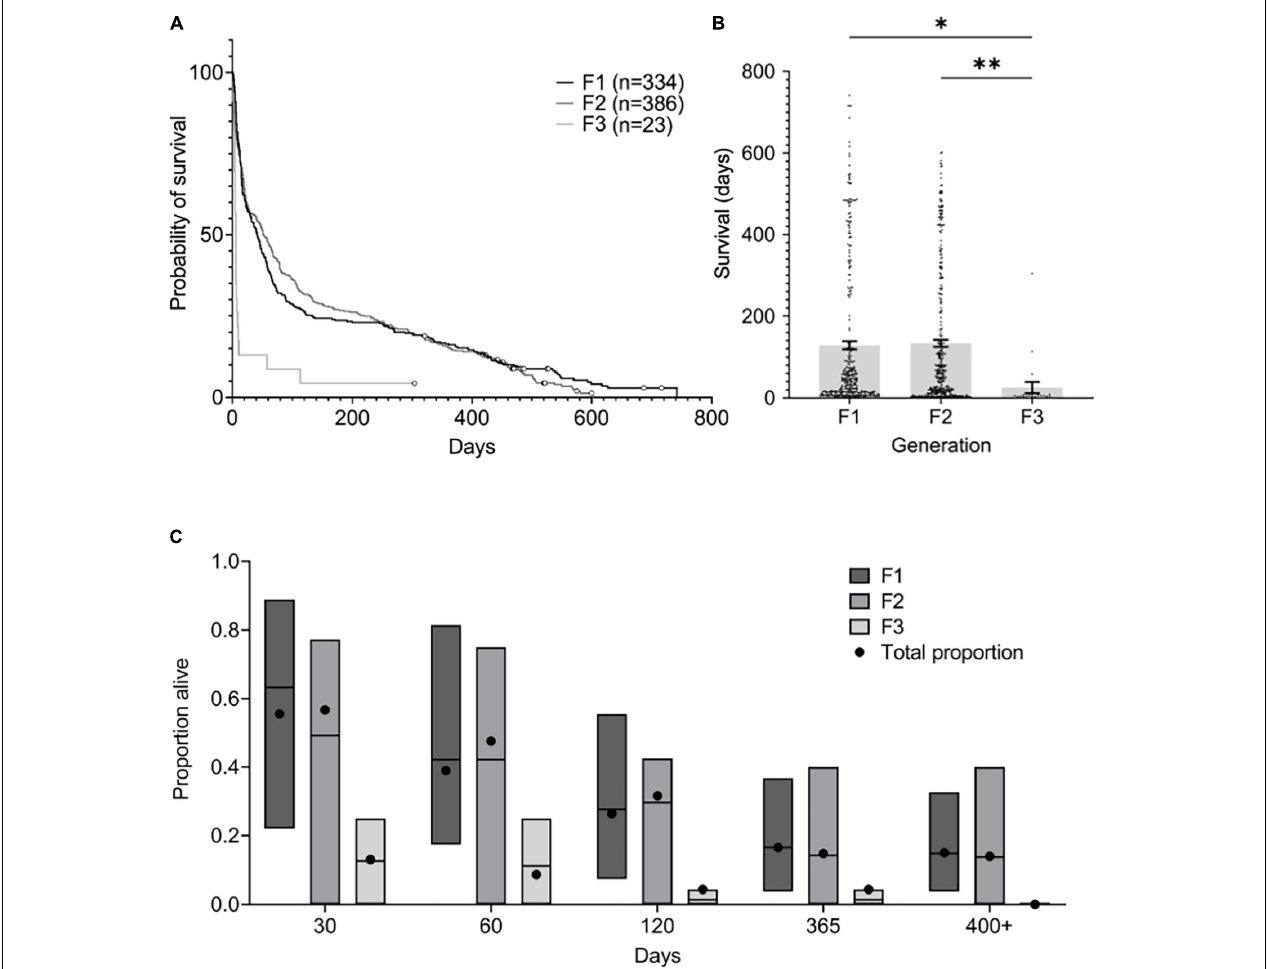
FIGURE 6 | Octopus chierchiae survival by generation. Mortality data was pooled and grouped by generation. (A) Survival curve by generation. Individuals surviving to the end of the study were treated as censored observations, represented by circles. (B) Survival (in days) by generation. Mean survival ( ± SEM) is reported by bars and individual survival is reported as black points. A one-way analysis of variance followed by Tukey’s multiple comparison test revealed that mean survival in the first and second generations was significantly higher than in the third generation. (C) Proportion alive at five timepoints by generation. Mean proportion alive per clutch and spread (minimum and maximum proportion) are reported by bars. Total proportion of all individuals alive in each generation is reported as black circles. F1, first generation; F2, second generation; F3, third generation; n , number of individuals; SEM, standard error of the mean; ∗ statistically significant at p ≤ 0.05; ∗∗ statistically significant at p ≤